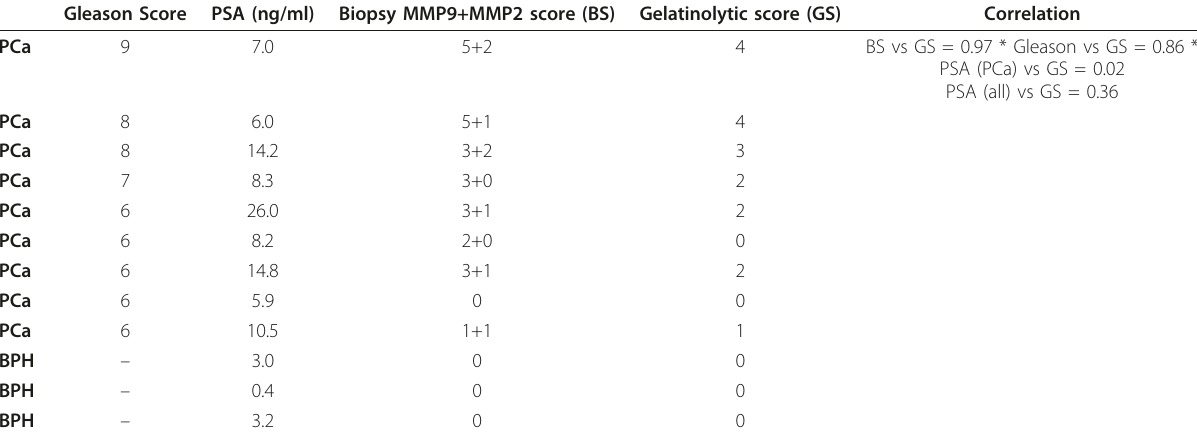
Table 1 Gelatinolytic score calculated for biopsy prints of PCa and BPH